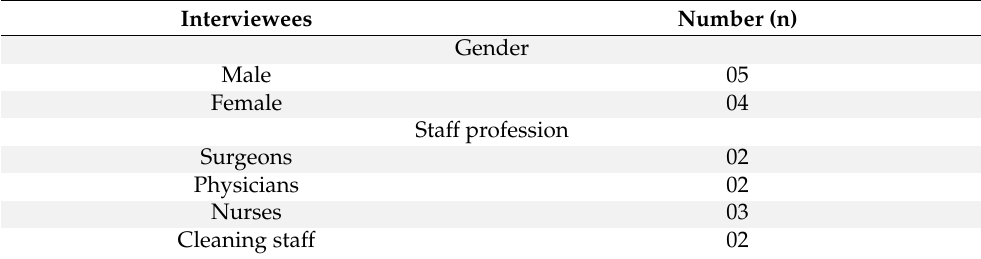
Table 1. Characteristics of